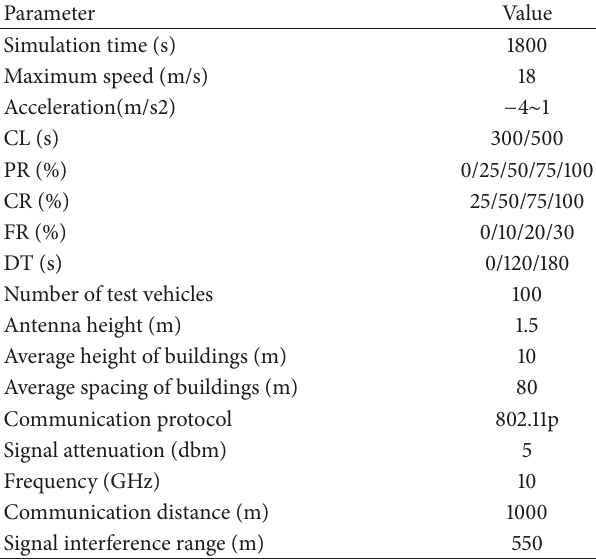
Table 2: CV characteristics indexes and parameters